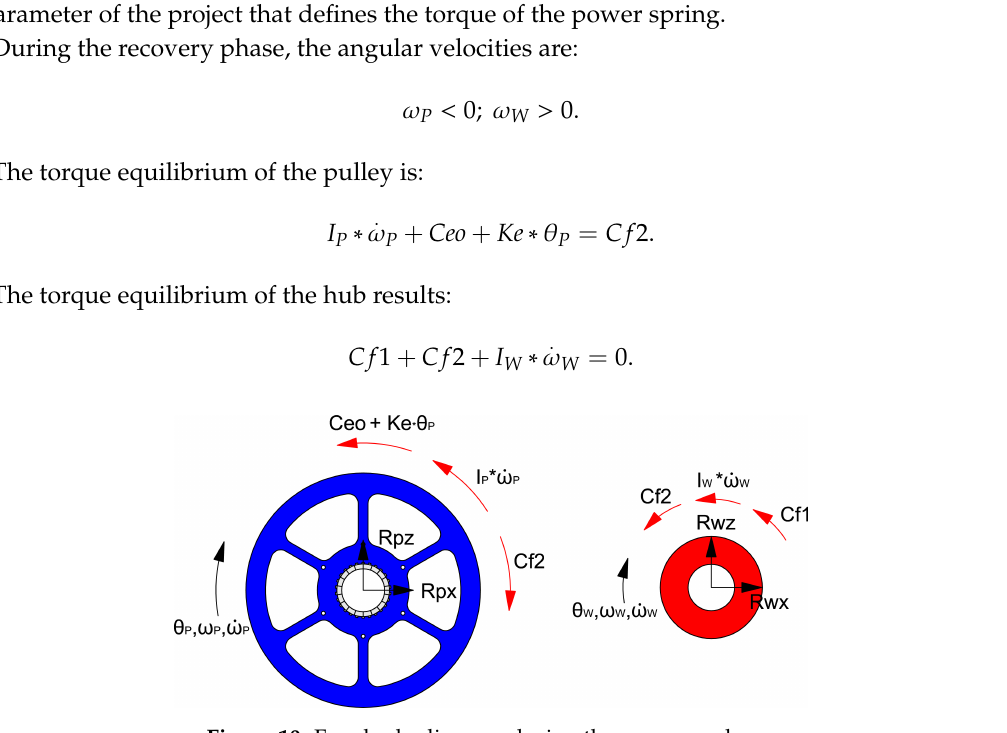
Figure 10. Free-body diagram during the recovery